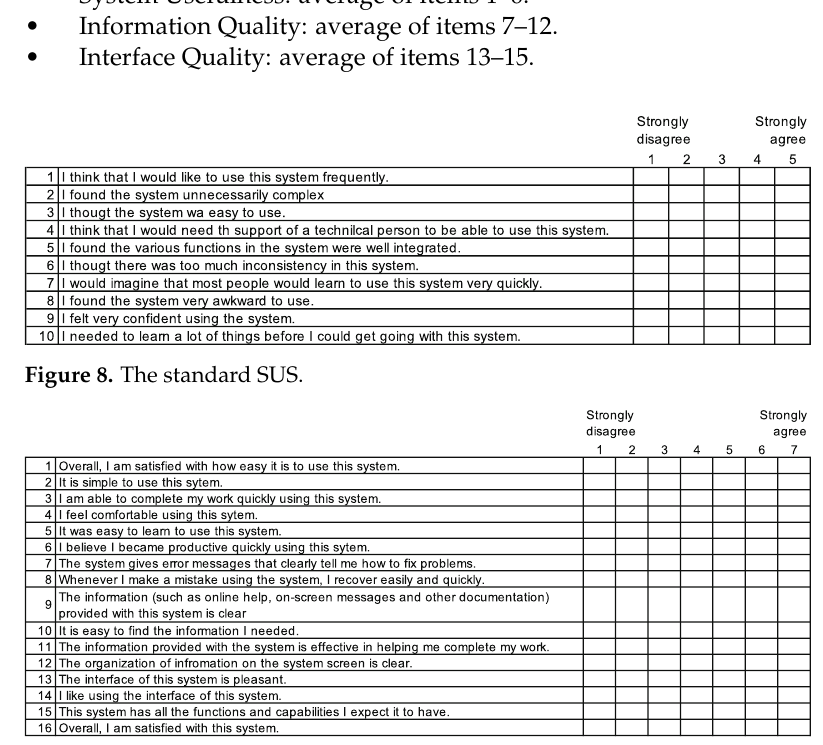
Figure 9. The standard CSUQ.